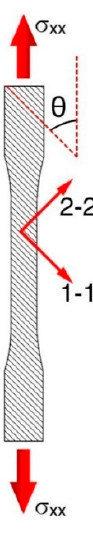
ff -axis loading Figure 4. Off-axis loading conditions. Figure 4. O